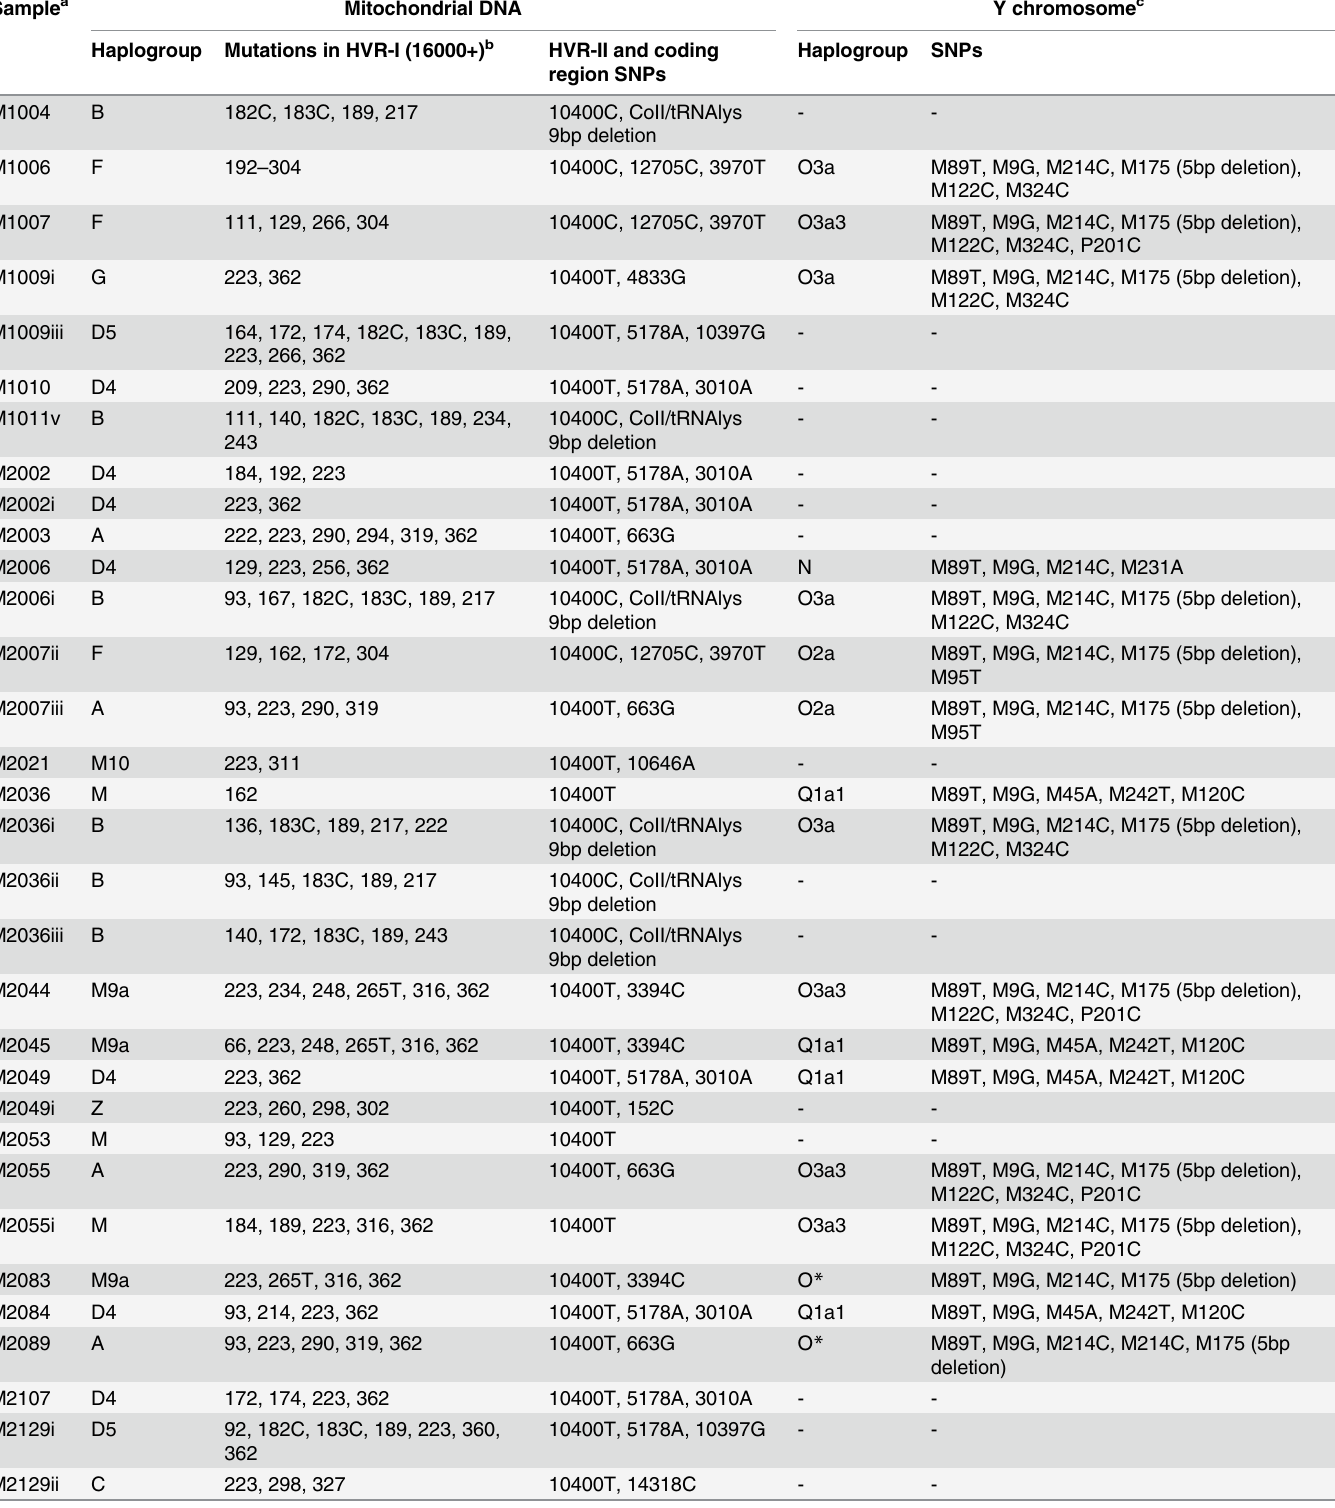
Table 1. Nucleotide differences in mtDNA and Y-SNP data from Hengbei